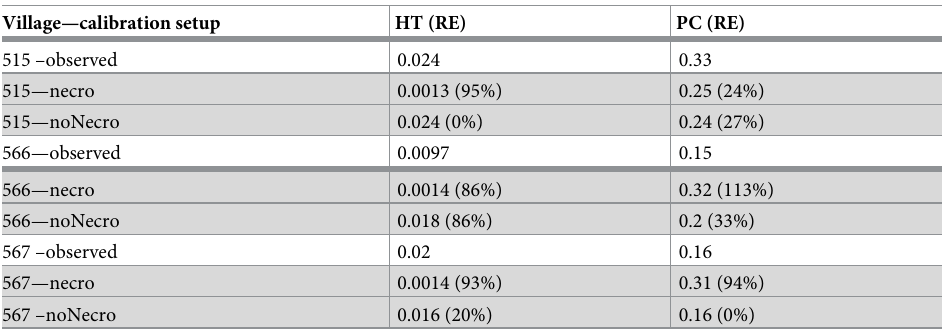
Table 5. Calibration results.